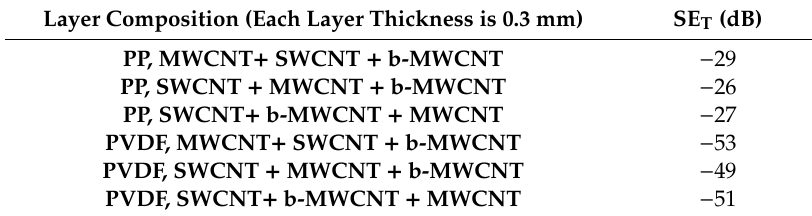
Figure 9. Shielding effectiveness of multi-layered stacks of PP with MWCNT + SWCNT + b-MWCNT and PVDF with MWCNT + SWCNT + b-MWCNT All composites contain 2 wt % CNT. Stack thickness: 0.9 mm. Table 3. Total shielding e ff ectiveness (SE T ) of multi-layer assemblies of 0.9 mm thickness at 18 GHz